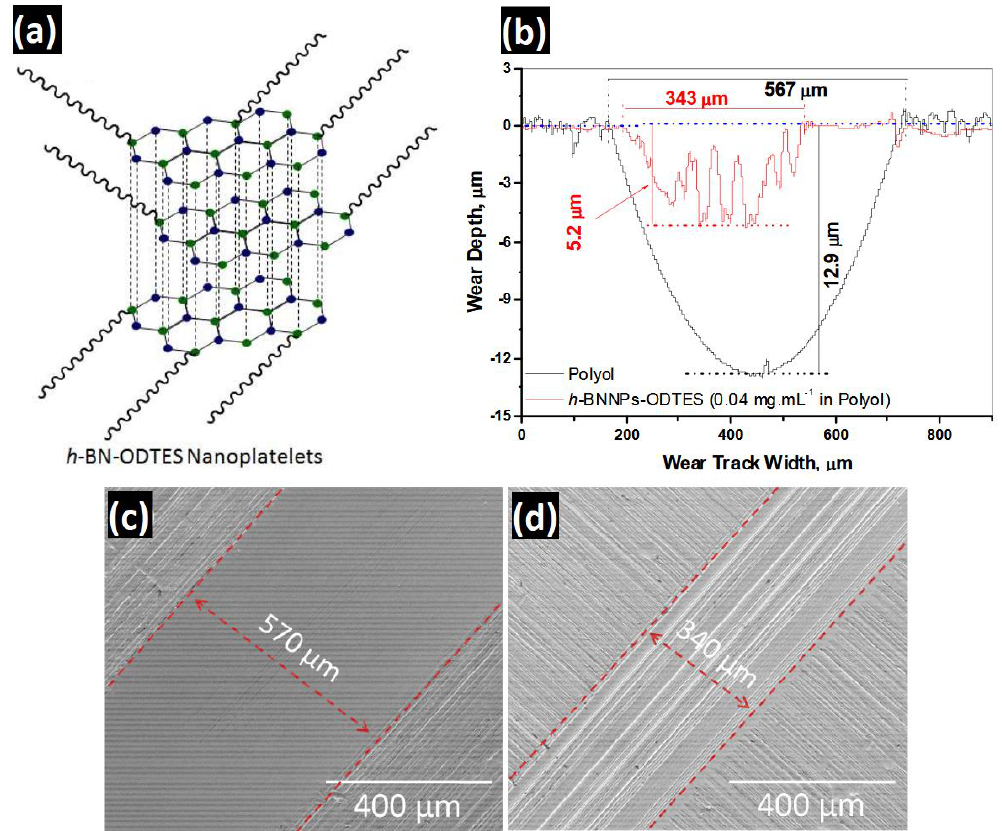
Figure 21. ( a ) Schematic of BNNS-ODTES structure. ( b ) Wear parameters of polyol ester lube oil with